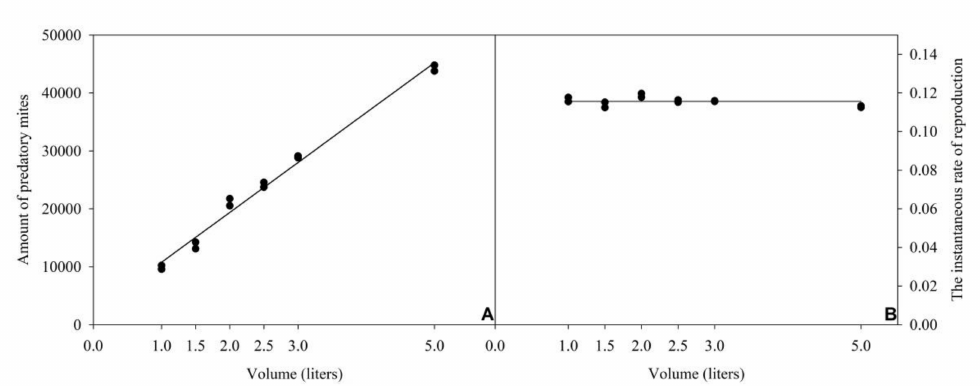
Figure 4. Relation between final density of Amblyseius tamatavensis ( A ) or instantaneous rate of reproduction ( B ) and volumes of containers, using a constant proportion between the amount of food provided and the number of inoculated predators (76 eggs and 160 post-embryonic stages of Thyreoph- agus cracentiseta : 0.3 A. tamatavensis /mL), for 30 days of production, at 25 ± 1 ◦ C, 70 ± 10% RH, in the